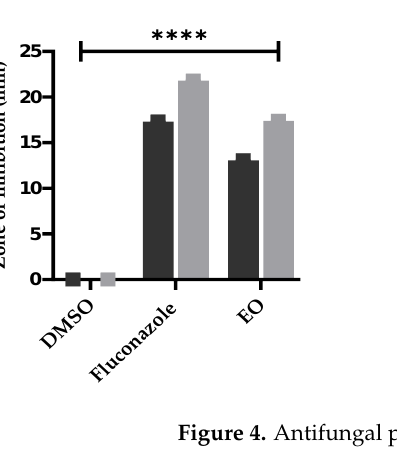
Figure 4. Antifungal potential of the E. larica essential oils against ( A ) A. parasiticus and ( B ) A. niger. DMSO was utilized as a negative control and fluconazole as a standard (positive control). All the data was taken in triplicate ( n = 3) and analyzed through two-way ANOVA, via Tukey’s multiple comparison test, ns = >0.9999, p = **** <0.0001.